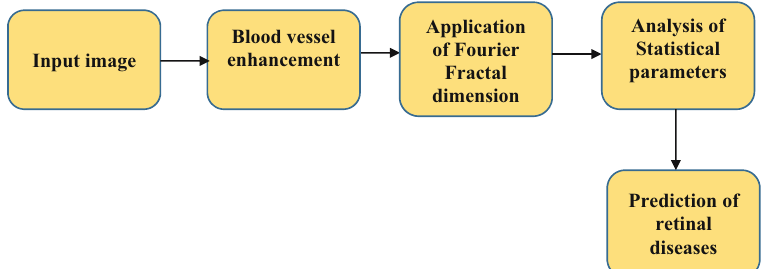
Figure 1: Flow diagram of the proposed